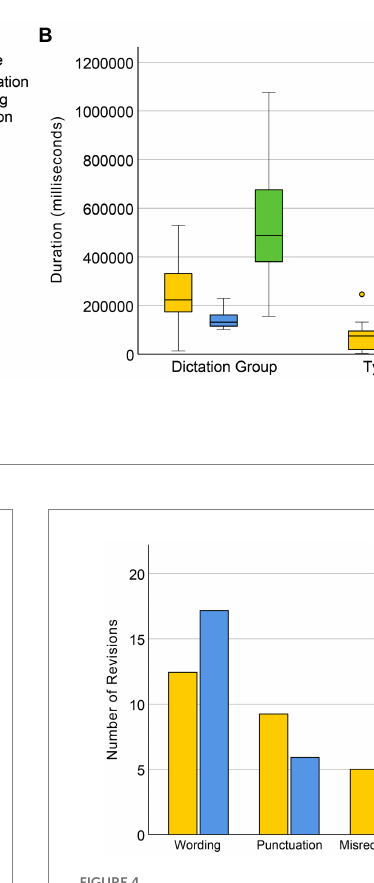
FIGURE 4 Comparison of revisions made by the dictation group in Texts 1 and 2.